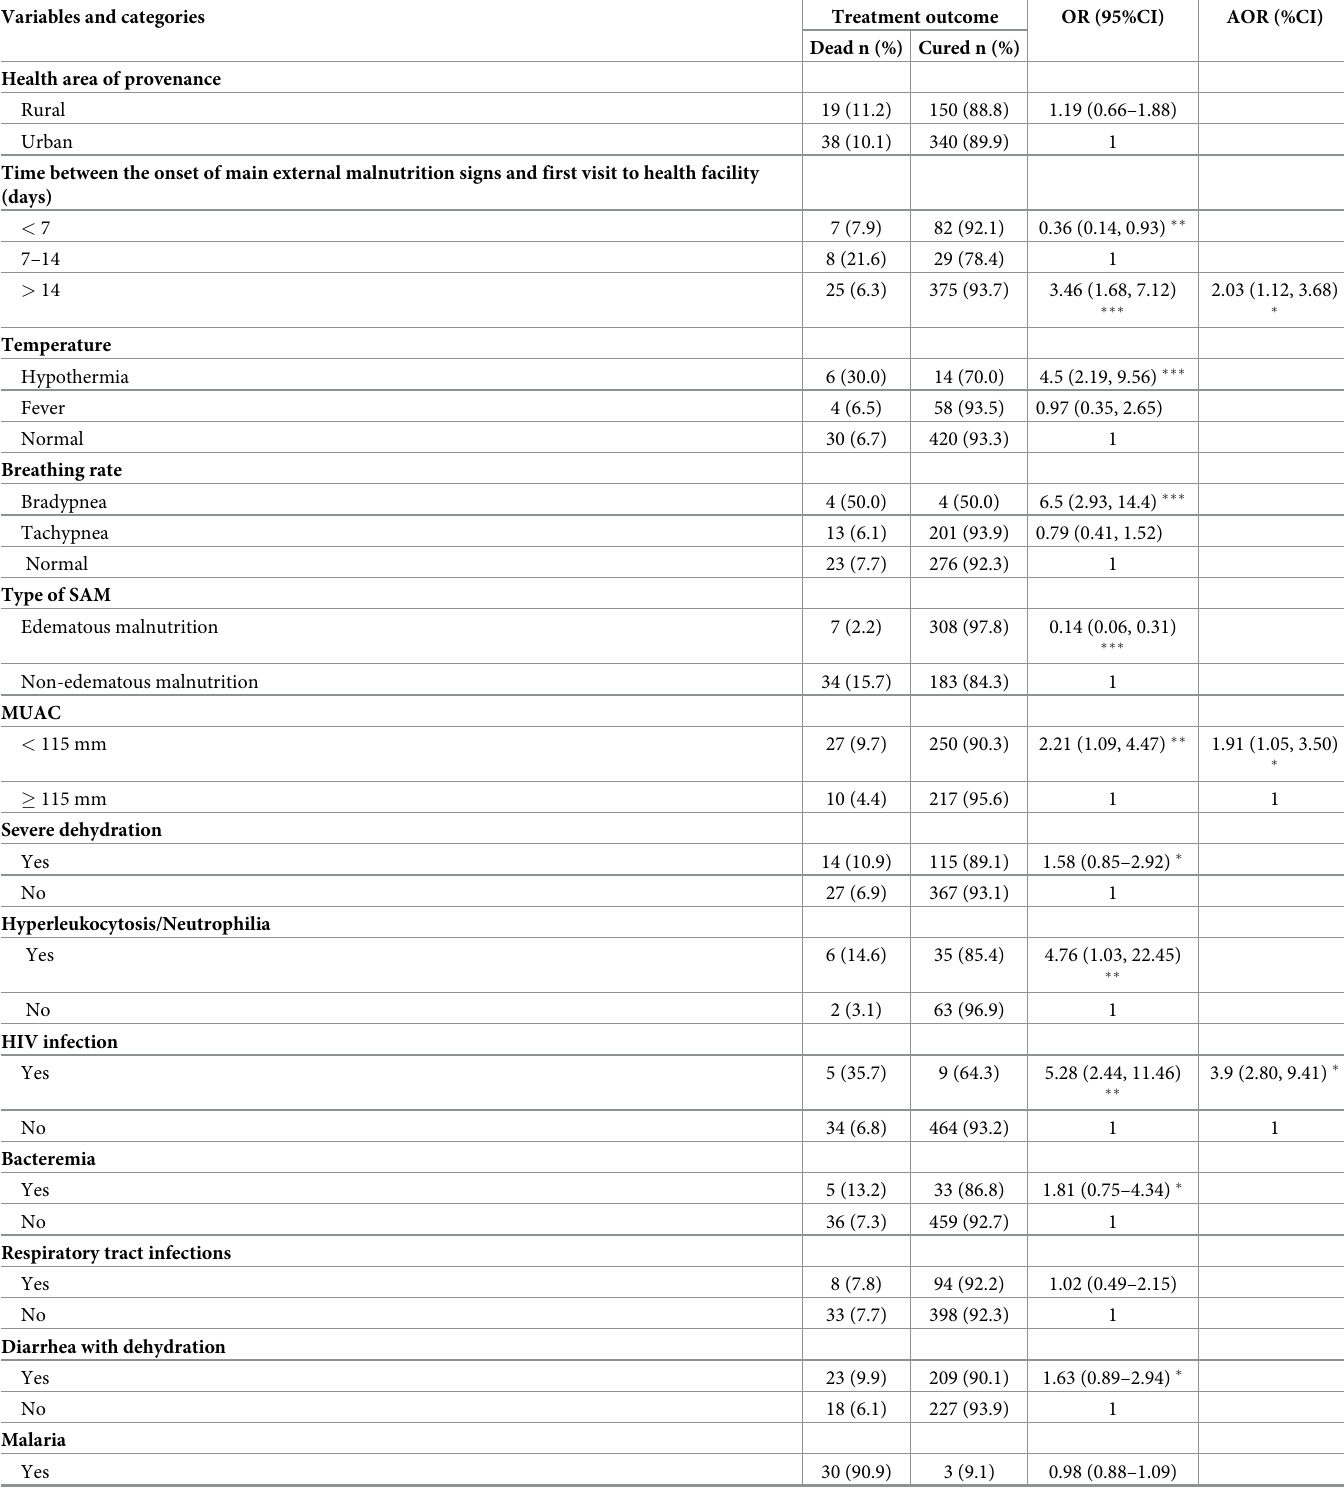
Table 3. Bivariate and multivariable analysis of factors associated with mortality of severely malnourished children at SJNC/HPGRB hospital, July 2017–December